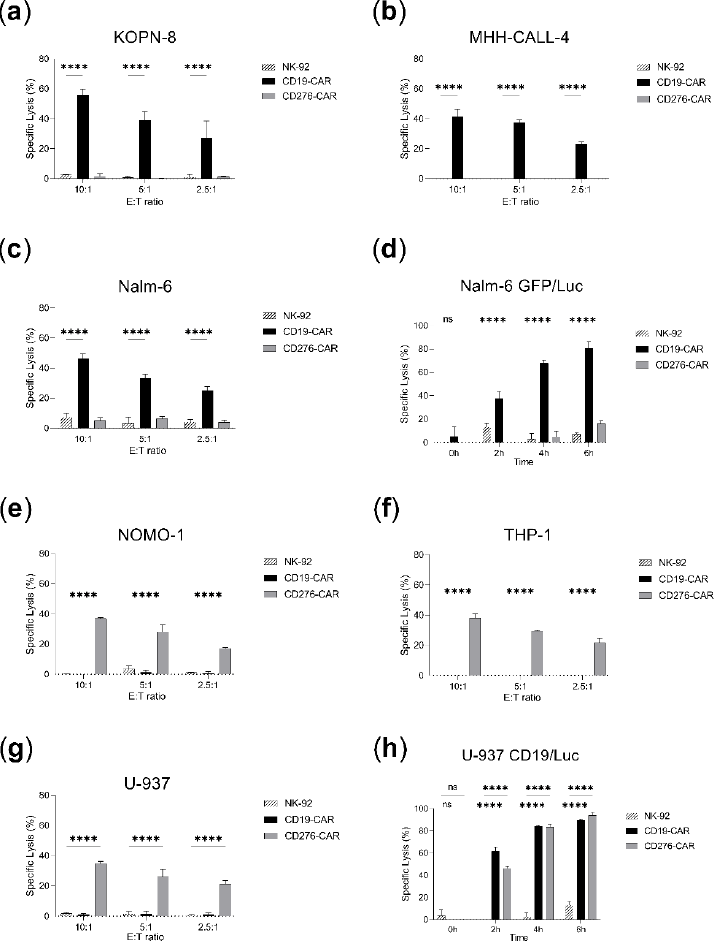
Figure 3. Cytotoxicity assays comparing NK-92 and CAR-NK-92 antileukemic performance. Specific lysis is shown as mean ± SD ( n = 3). Calcein assays were incubated for 2 h and several effector-to- target (E:T) ratios were employed: 10:1, 5:1, 2.5:1. Luciferase assays were performed over a time span of 6 h in 5:1 E:T ratio. ( a ) KOPN-8 calcein assay. ( b ) MHH-CALL-4 calcein assay. ( c ) Nalm-6 calcein assay. ( d ) Nalm-6 GFP/Luc luciferase assay. ( e ) NOMO-1 calcein assay. ( f ) THP-1 calcein assay. ( g ) U-937 calcein assay. ( h ) U-937 CD19tag/Luc luciferase assay. **** p < 0.0001, ns, non-significant ( p > 0.05).